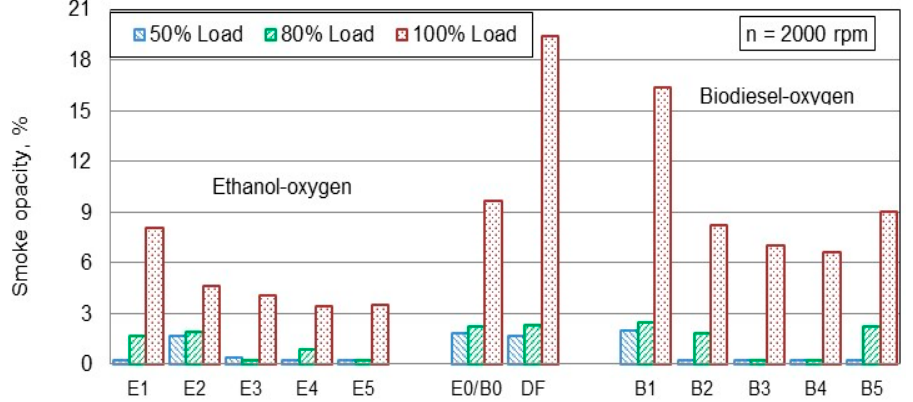
Figure 14. Effect of ethanol–oxygen or biodiesel-oxygen mass content (wt%) in fuel blends on exhaust smoke when running under medium (50%), intermediate (80%), and full (100%) loads corresponding to the respective IMEPs of 0.75, 1.20, and 1.50 MPa, developed at maximum torque speed of 2000 rpm.